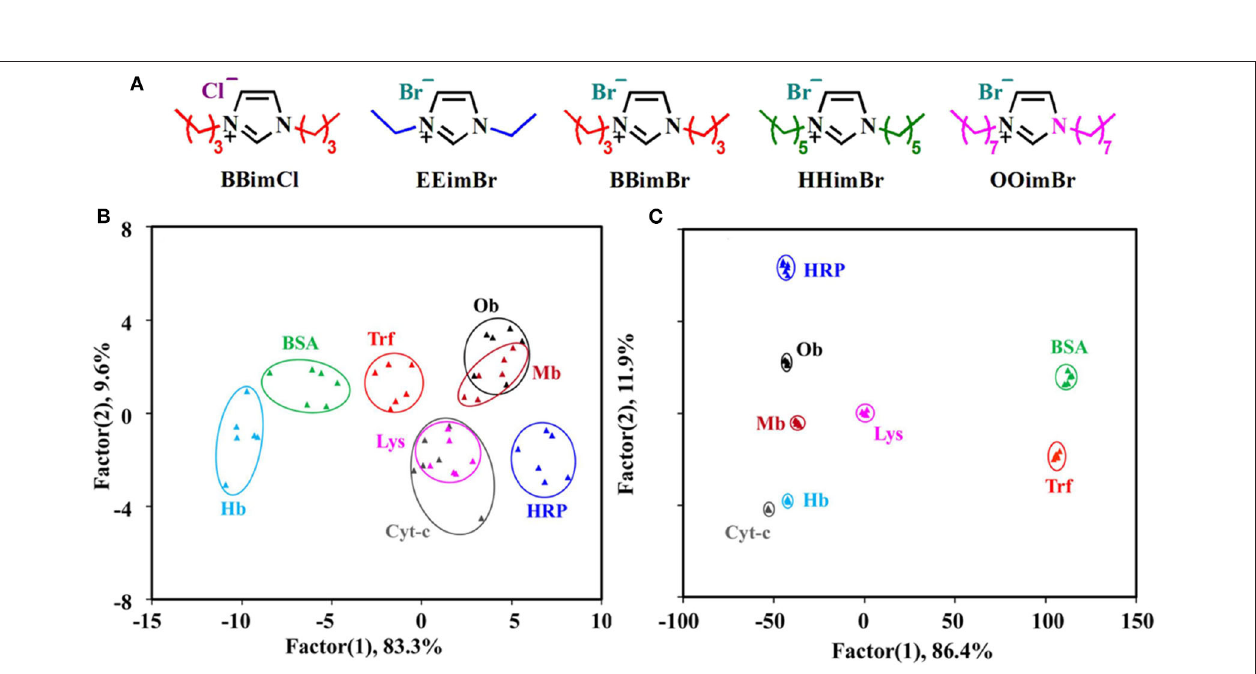
Frontiers in Chemistry |